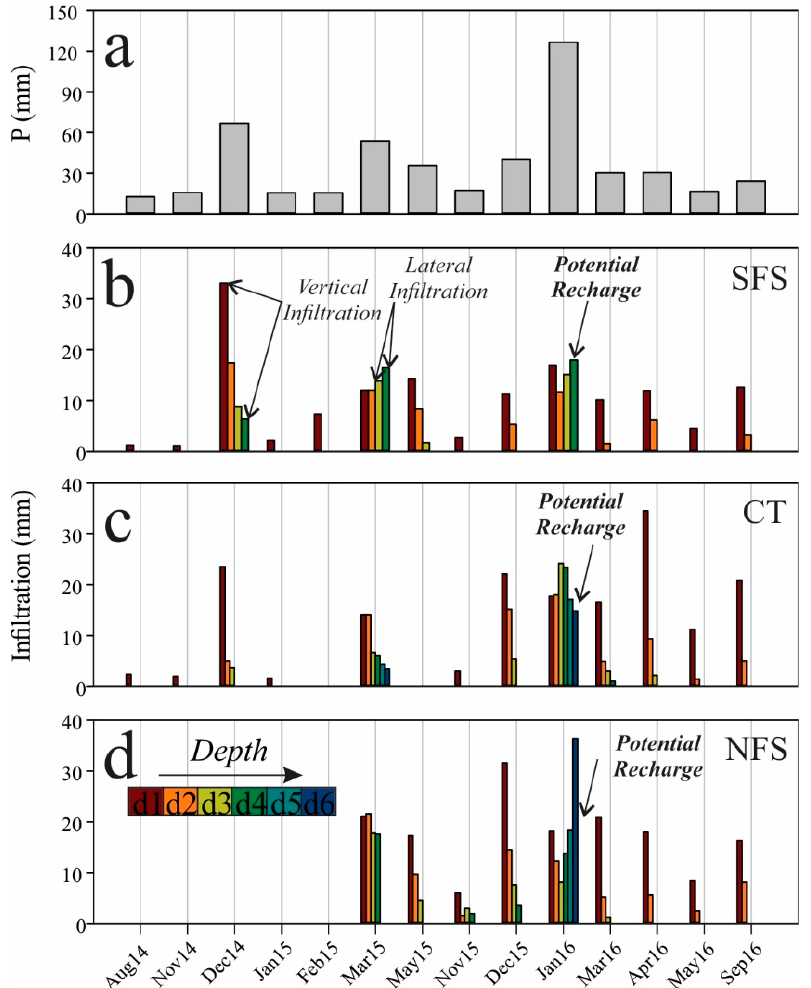
Figure 10. ( a ) Accumulated monthly precipitation and ( b – d ) total infiltration for each soil depth interval (d1 to d6) for events with P > 7 mm. Note that SFS is limited to 0.4 m (d4), while CT and NFS extend to 1 m (d6). SFS ( b ), CT ( c ) and NFS ( d